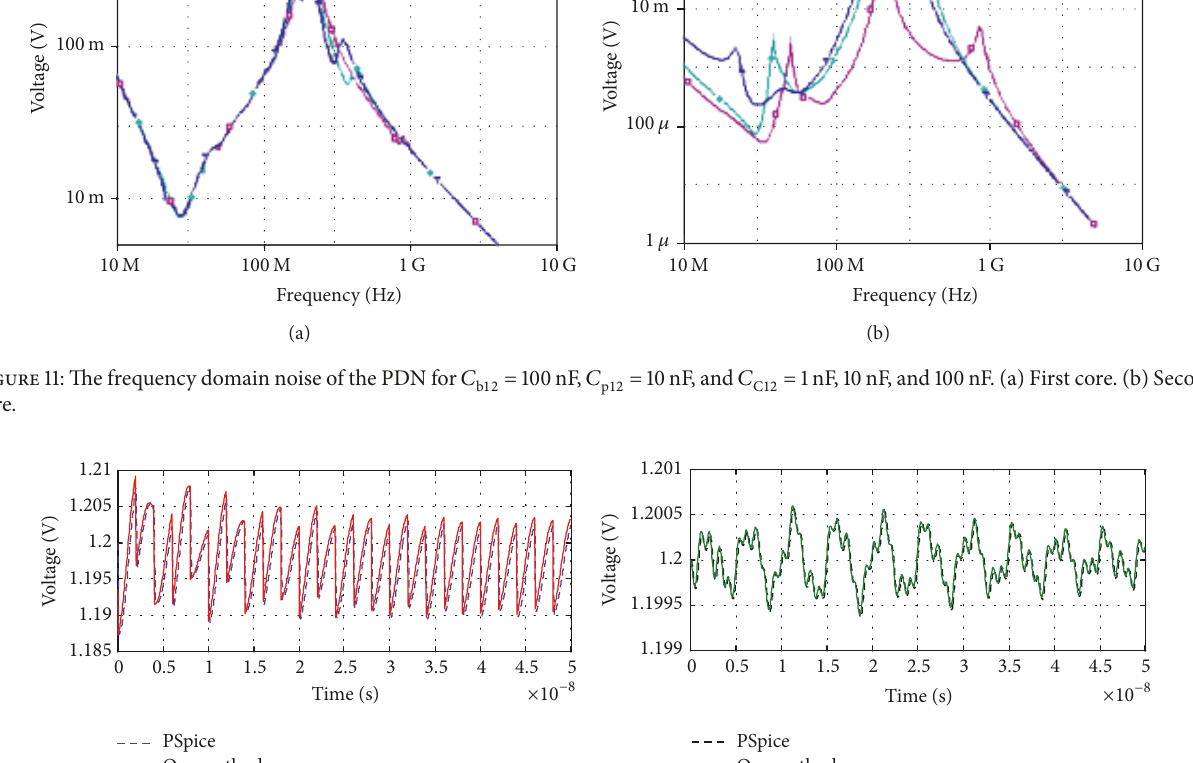
= 100nF, 𝐶 = 10nF, and 𝐶 = 1nF. (a) 𝐼 2 = 1 A. (b) 𝐼 2 = 0 A. b 12 p 12 c 12